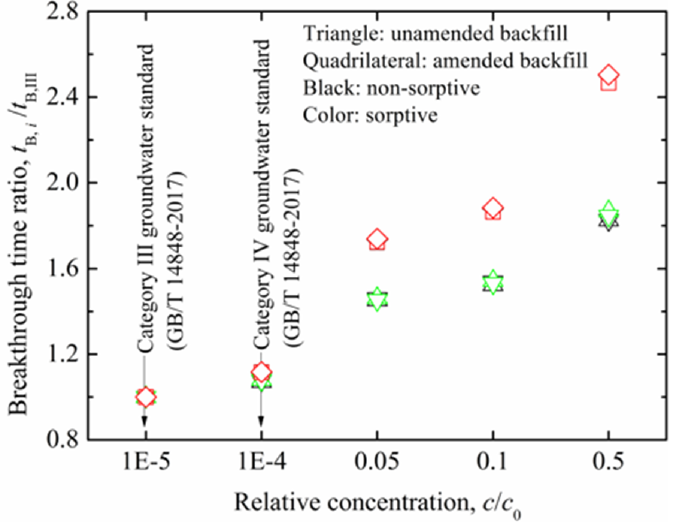
Figure 6. Relationship between breakthrough time ratio and relative concentration for unamended and amended backfills with source Pb concentration = 1000 mg/L and wall thickness = 1 m.